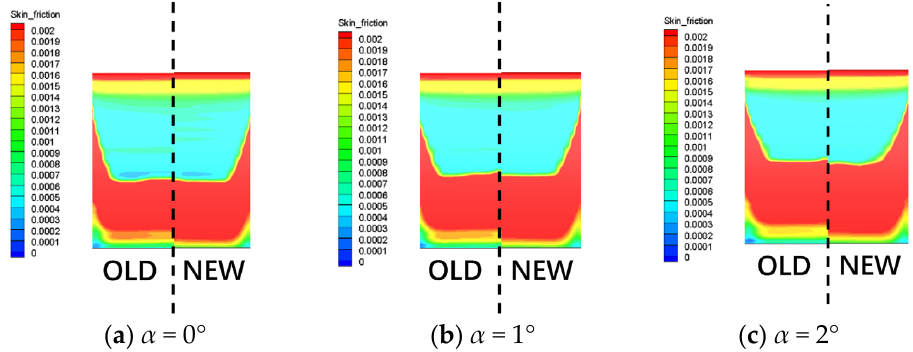
Figure 26. Comparison of the skin friction coefficient contour of the central experimental wing.